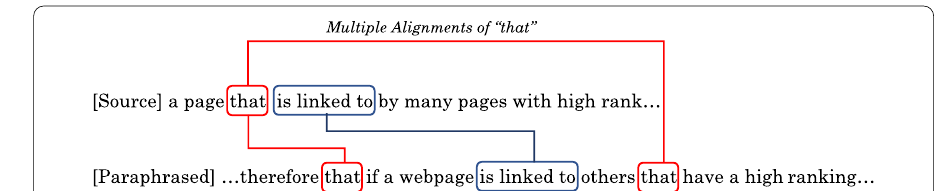
Fig. 7 Alignment of identical text fragment of size 3 and possible multiple alignments for